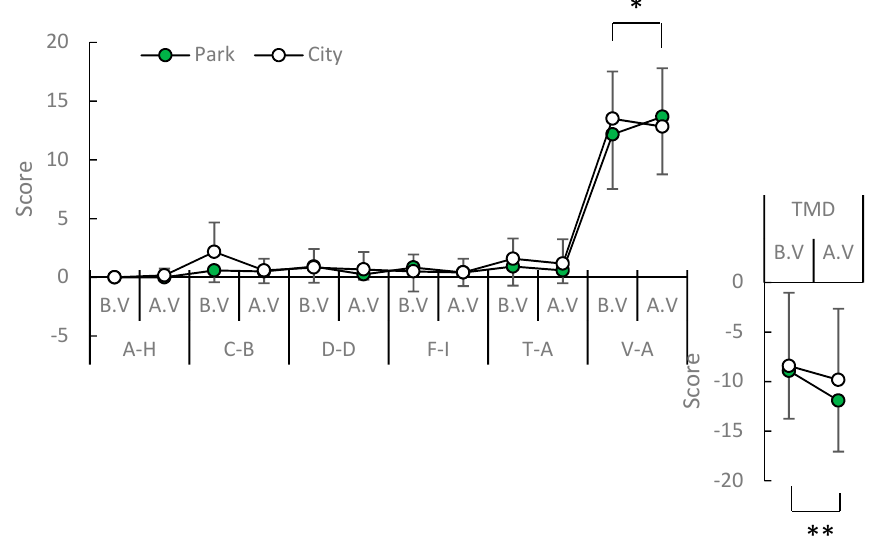
Figure 7. Comparison of POMS score pre and post-view in the urban park in the spring. A–H: anger–hostility; C–B: confusion–bewilderment; D–D: depression–dejection; F–I: fatigue–inertia; T–A: tension–anxiety; V–A: vigor–activity. N = 12, mean ± standard deviation. * p < 0.05, ** p < 0.01, determined by the Wilcoxon signed-rank test (one-sided).